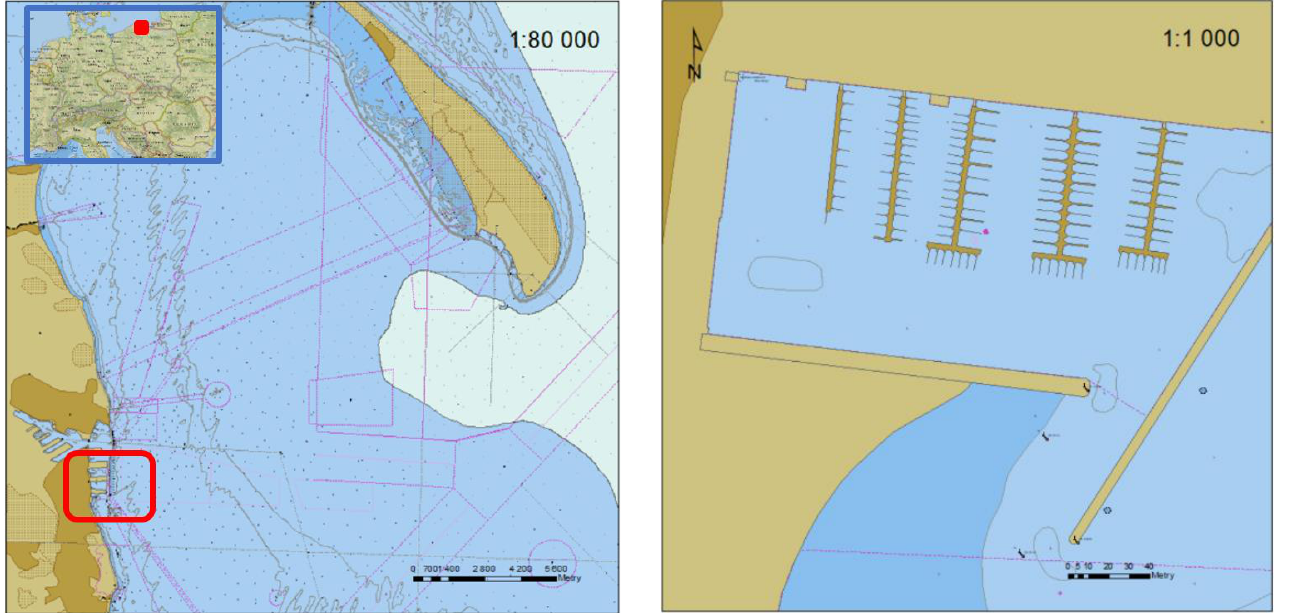
Figure 1. The restricted area of USV surveys and heading/course measurements. Three devices enabling the course of the USV to be plotted were used for this